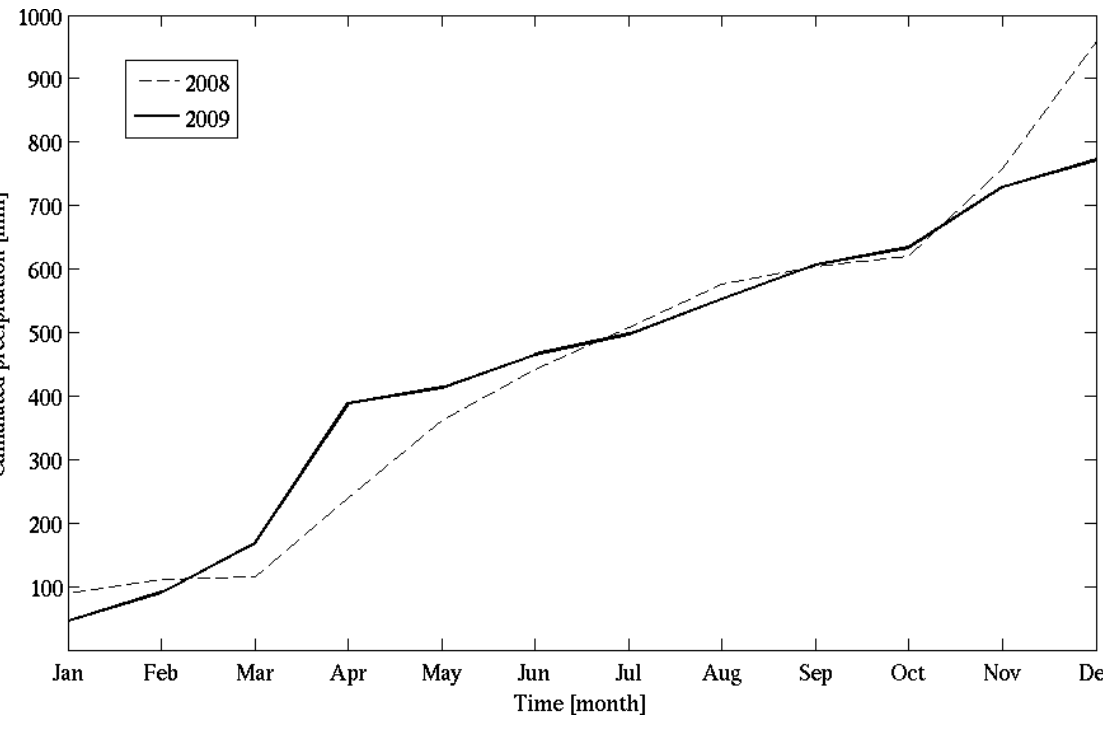
Figure 4. Monthly cumulated precipitation (in mm) measured at Cocconato vineyard in 2008 and 2009.